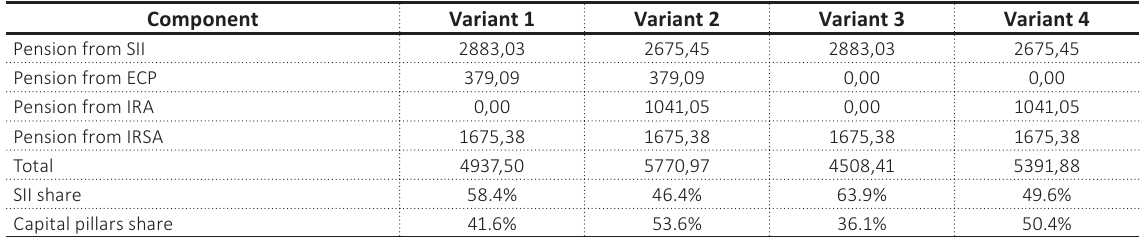
Source: Own calculations based on the data from Tables 6, 8, 10, and